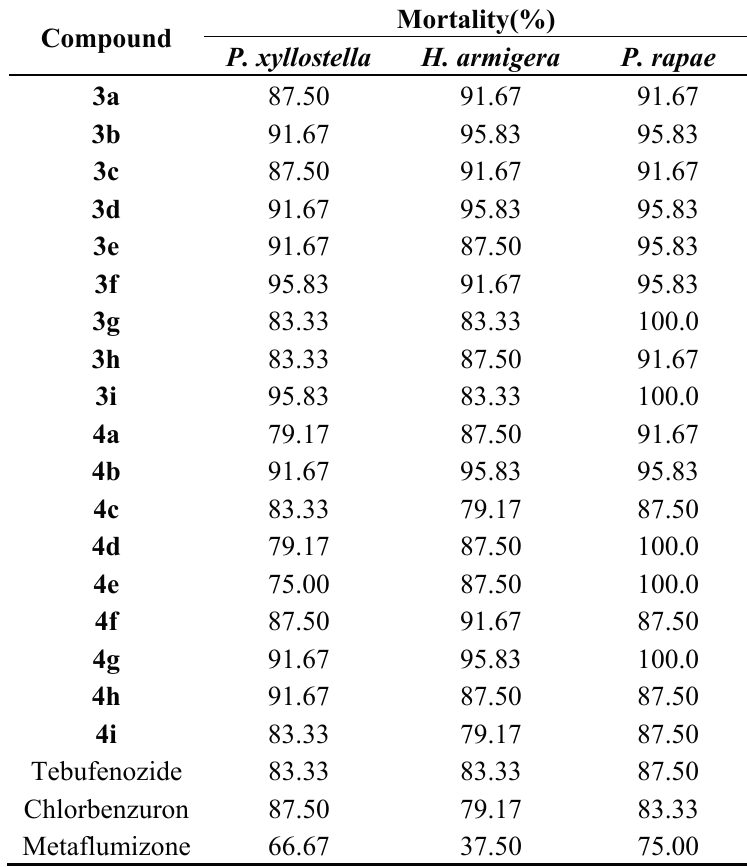
Table 2. Insecticidal activities of phenylurea derivatives (Concentration of 10 mg/L, 72